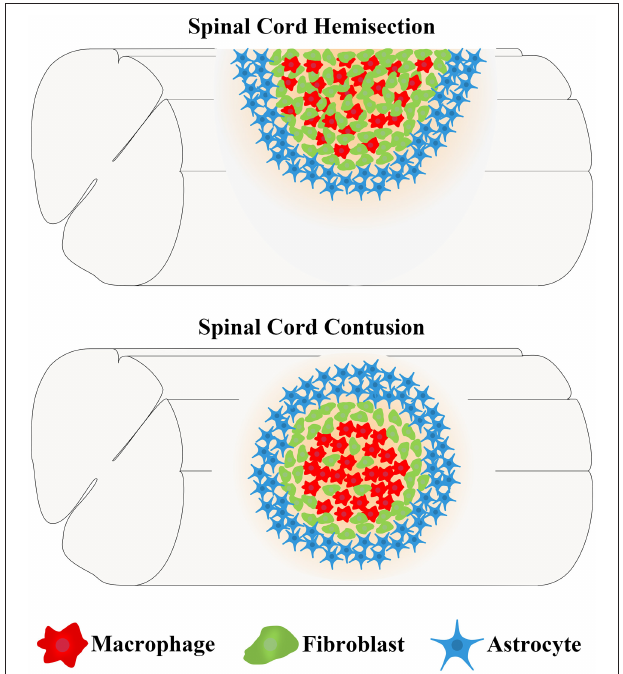
FIGURE 1 | Differences in the locations of fibrotic scar between the spinal cord hemisection model and contusion model in mice. After spinal cord injury (SCI), fibroblasts form a fibrotic scar adjacent to the medial side of the astrocytic scar formed by astrocytes. The fibrotic scar after spinal cord hemisection injury fills the entire injured core and is mixed with macrophages, while the fibrotic scar formed after spinal cord contusion injury exhibits a dense and contiguous scar structure at the edge of the injured core that is filled with a large number of macrophages.